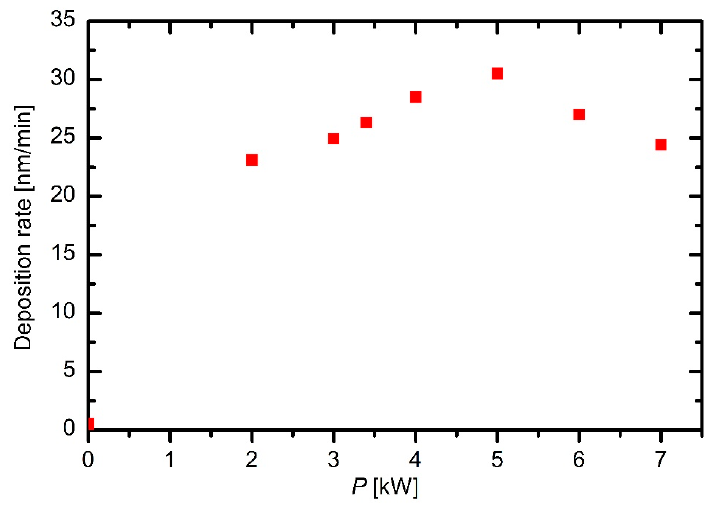
Figure 8. Deposition rates versus discharge power at an HMDSO flow of 130 sccm.